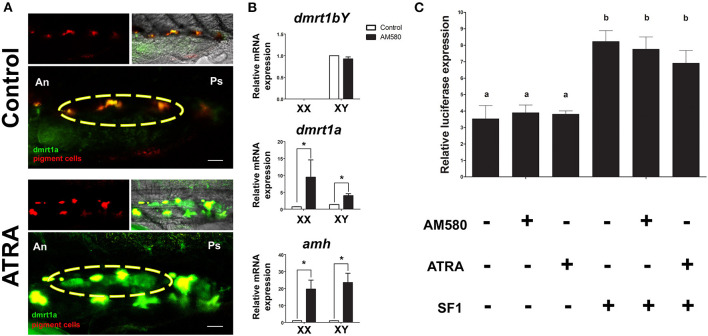
Regulation of sexual development genes after RA pathway activation. (A) Long-term treatments of BACdmrt1a::GFP medaka embryos led to gonad (yellow circle) specific induction of dmrt1a at 1 dah. (B) Expression levels of dmrt1bY, dmrt1a, and amh at 1 dah after long-term treatments with AM580. No effect on dmrt1bY expression is observed, however, significant upregulation of dmrt1a and amh occurred in embryos of both sexes. Values are expressed as arbitrary mRNA units normalized against the expression levels of ef1a amplified from the same template and relative to the average expression of control male and female embryos. Asterisk indicates a significant difference (p < 0.05) after Student's t-test comparing the expression between control and AM580 treatments. (C) The dmrt1a promoter activity was higher when co-transfected with medaka SF1, but no significant luciferase signal was observed after treatments with both ATRA and AM580. Scale bar = 60 μm.